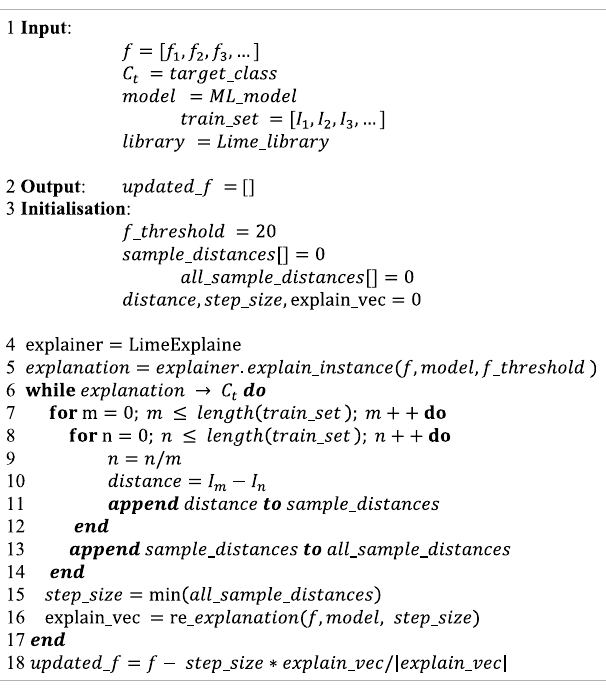
Frontiers in Arti fi cial Intelligence |